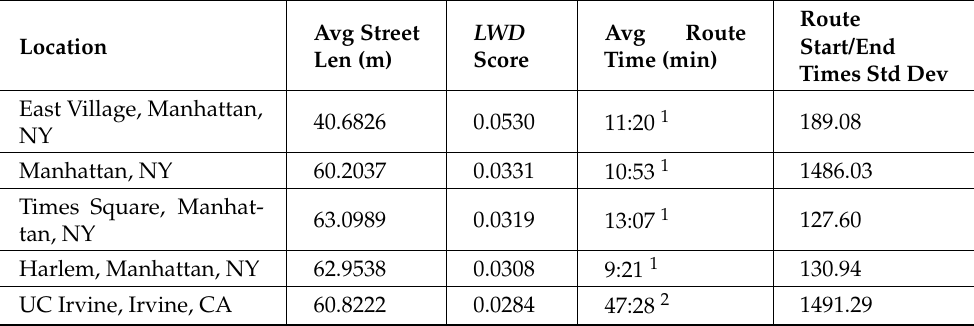
Table 1. Various regions of Manhattan and corresponding datasets compared to the UCI campus and